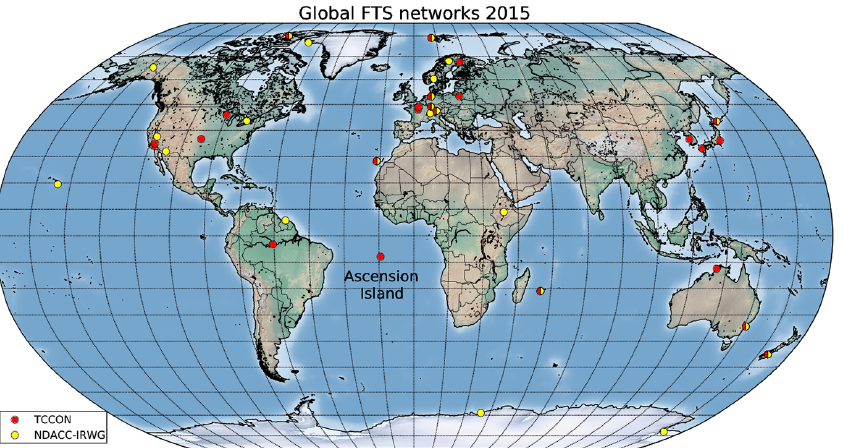
Figure 1. Map of active FTS sites in the TCCON and NDACC’s Infrared Working Group (IRWG). The MPI-BGC’s FTS is located on Ascension Island in the South Atlantic